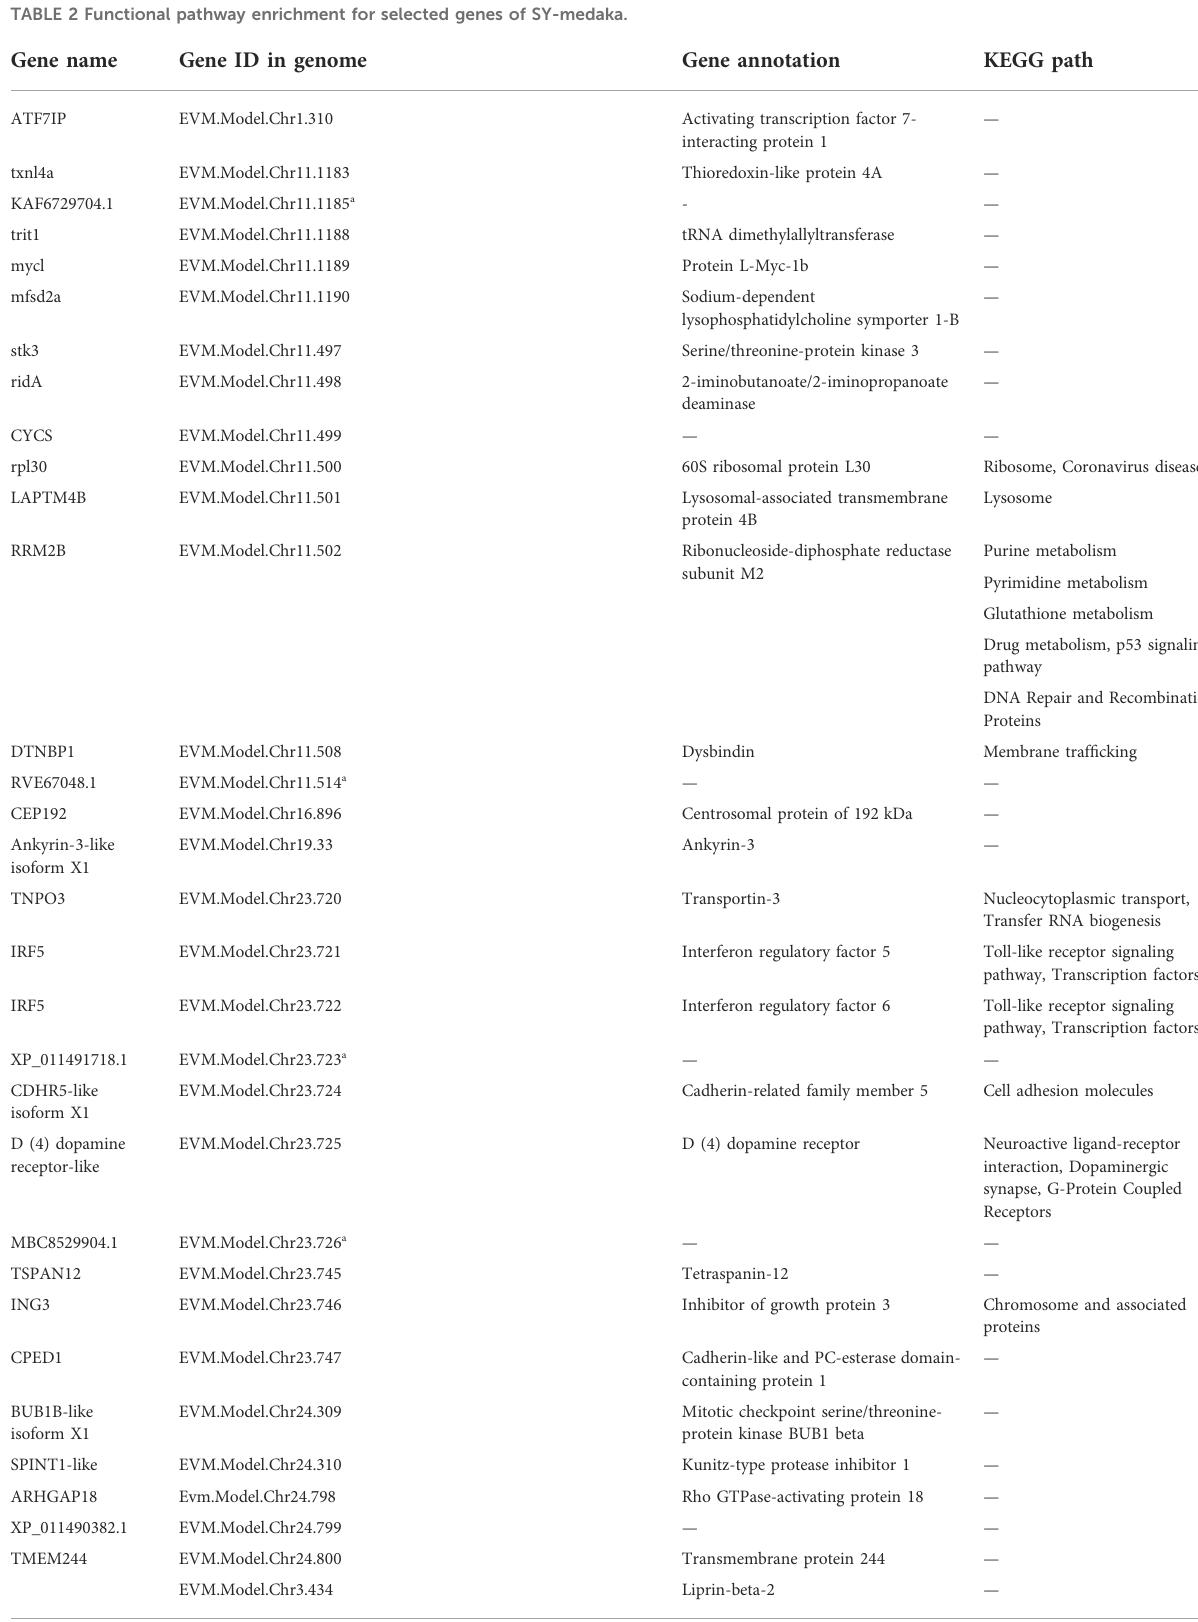
TABLE 2 Functional pathway enrichment for selected genes of